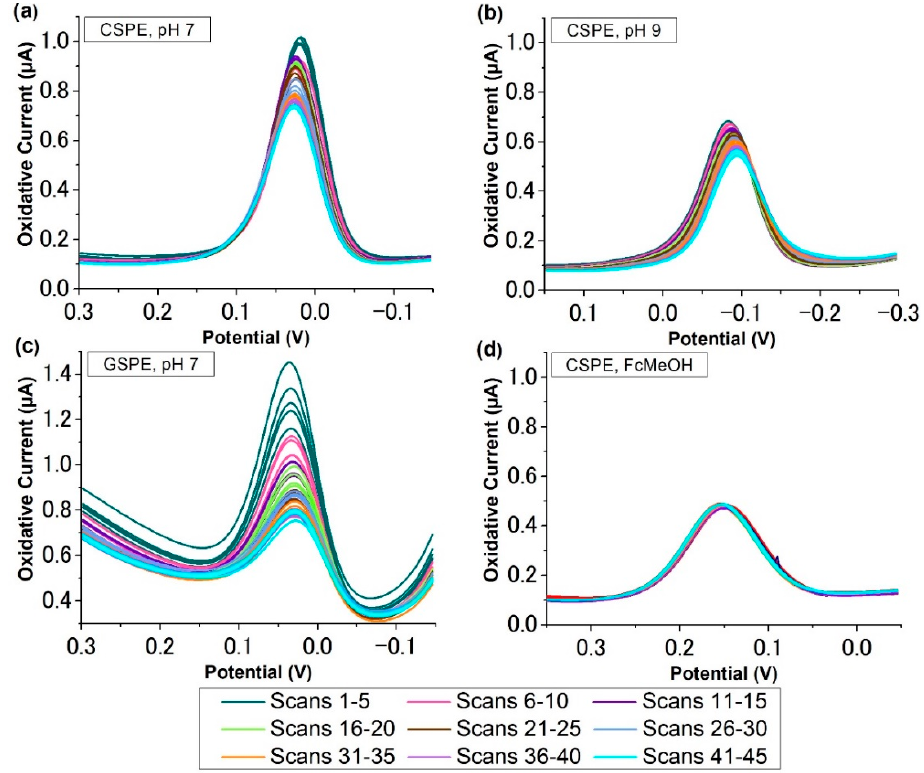
Figure 6. Forty-five SWVs of ( a ) 25 μ M PAP at pH 7 on a CSPE, ( b ) 25 μ M PAP at pH 9 on a CSPE, µ M PAP at pH 7 on a GSPE, and ( d ) 25 µ M FcMeOH on a ( c ) 25 μ M PAP at pH 7 on a GSPE, and ( d ) 25 μ M FcMeOH on a CSPE. ( c ) 25